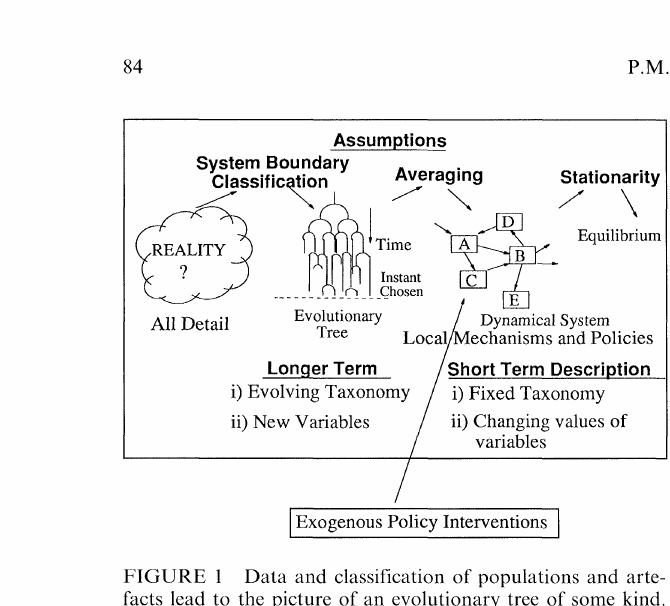
Data and classification of populations and arte- facts lead to the picture of an evolutionary tree of some kind. Mathematical models have concentrated on the causal rela- tions at a given